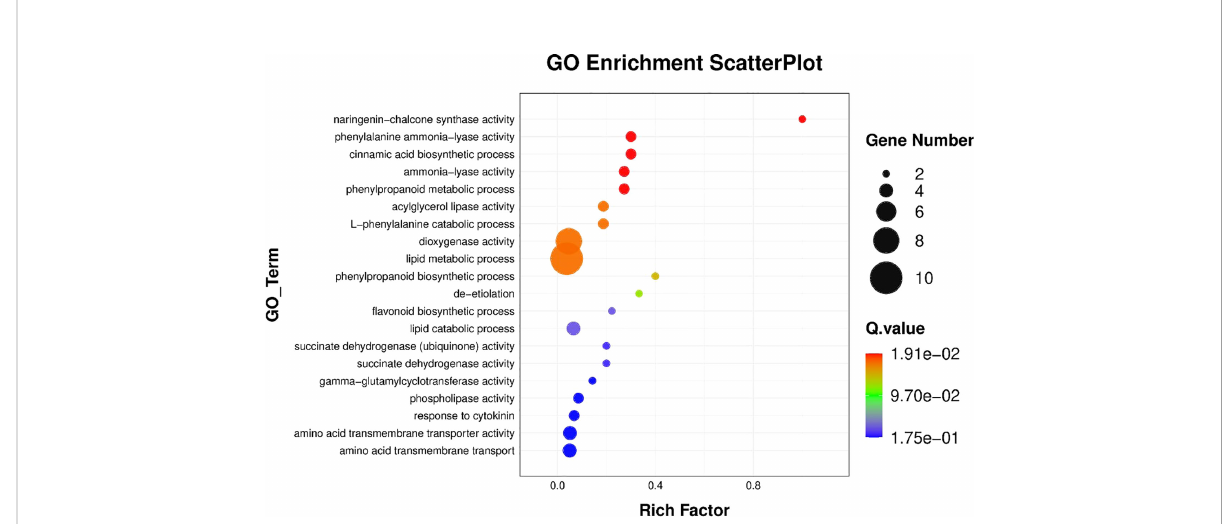
FIGURE 5 KEGG pathway enrichment scatter plot. The vertical axis represents the path name, and the horizontal axis represents the path factor corresponding to the rich